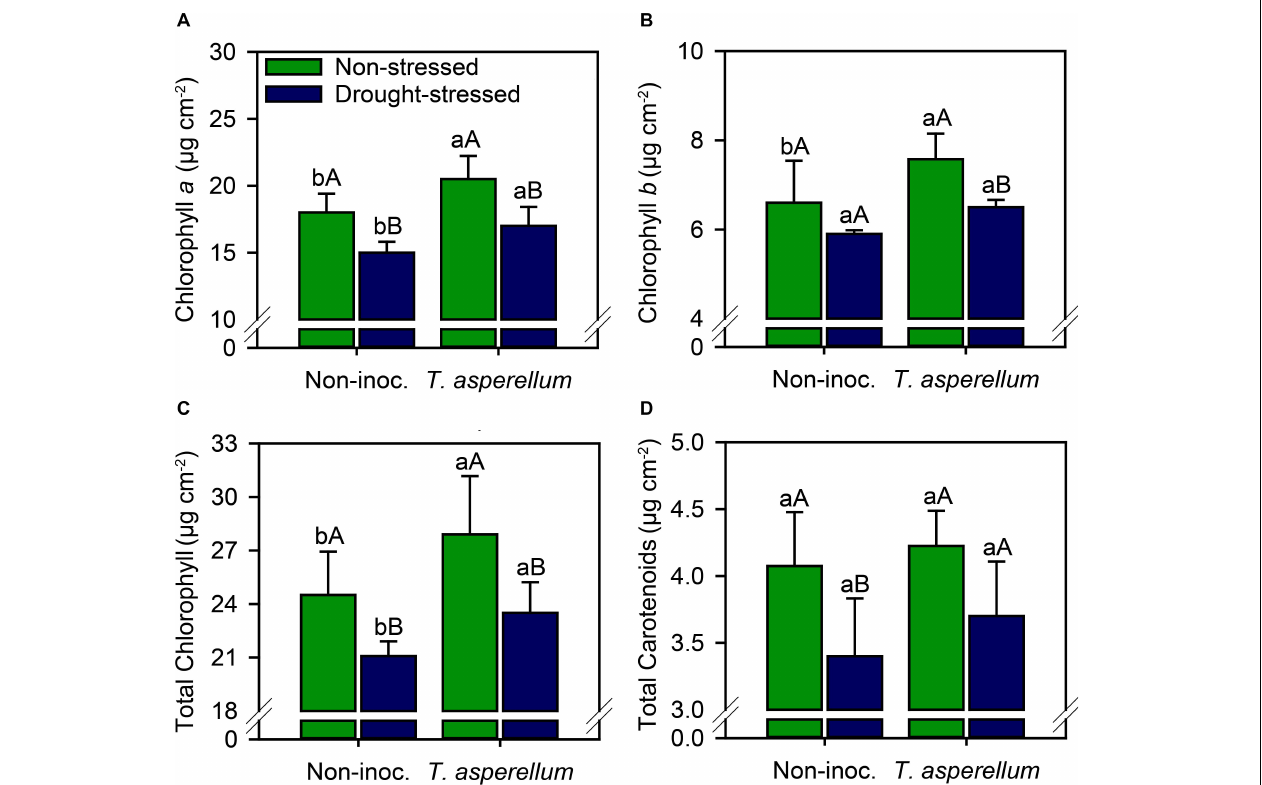
FIGURE 2 | Chlorophyll a (A) , chlorophyll b (B) , total chlorophyll (C) , and total carotenoid (D) concentrations in sugarcane leaves according to the treatments. Different lowercase letters indicate significant differences between presence and absence of moderate drought stress, and different capital letters indicate significant differences between presence and absence of inoculation with T. asperellum by Fisher’s protected LSD test at p ≤ 0.05. Error bars express the standard error of the mean ( n = 4).